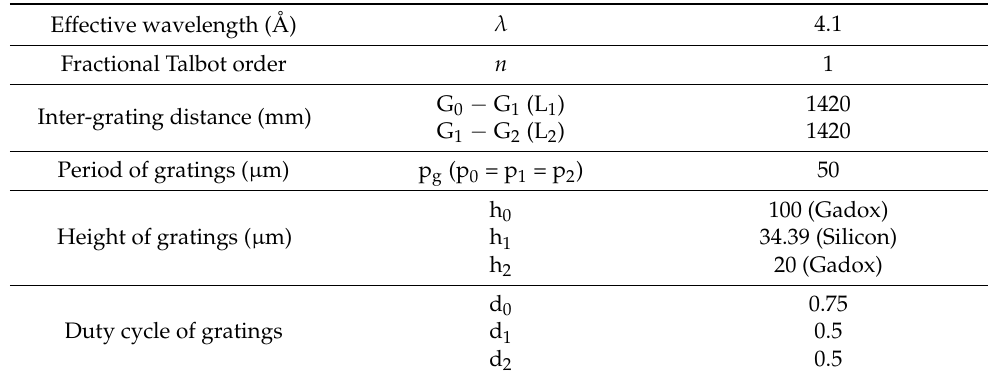
Table 1. The detailed parameters of the Talbot–Lau neutron-grating interferometer. Effective wavelength